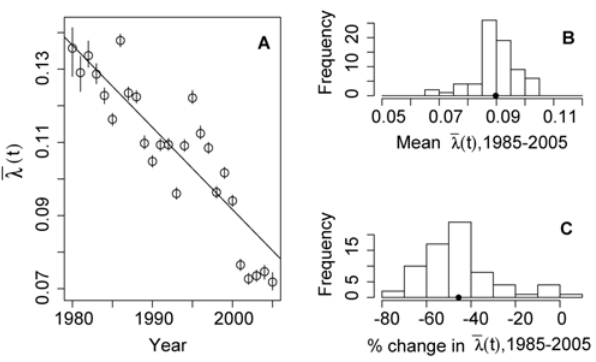
Figure 2. The force of infection of dengue in Thailand, 1980– 2005. (A) Estimates of the force of infection (per year) for each year, 1980–2005 in Thailand estimated using age-specific case data aggregated at the national level and model 3 (see Text S1). 95% CIs are indicated by vertical bars. The line drawn is the least squares linear regression weighted using the reciprocal of width of CIs on each point. This linear trend shows a reduction in the force of infection of 0.002 per year ( p , 1e 2 6). (B) Histogram of mean forces of infection averaged over the interval 1985–2005 estimated using data from each of the 72 provinces of Thailand. Histogram shows the frequency of 72 estimates occurring in the ranges indicated on the x -axis. (C) Histogram of changes in forces of infection over the interval 1985–2005 estimated using data from each of the 72 provinces of Thailand. Histogram shows the frequency of 72 estimates of the change in force of infection occurring in the ranges indicated on the x -axis. We estimated changes using weighted least squares regression of annual estimates of the force of infection in each location. doi:10.1371/journal.pmed.1000139.g002 p , 0.001). Text S1, table S1 summarizes each of the models estimated and measures of their goodness of fit. The fit of three of these models to the age-specific incidence data for 5 y is found in Figure 3. Visually, the models fit the data well. The figure shows that models that include age-specific factors (models 3 and 4) fit